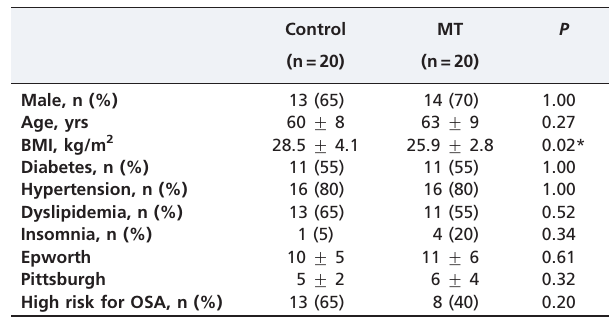
Table 1 - Demographic and clinical characteristics of participants from the control and MT groups.